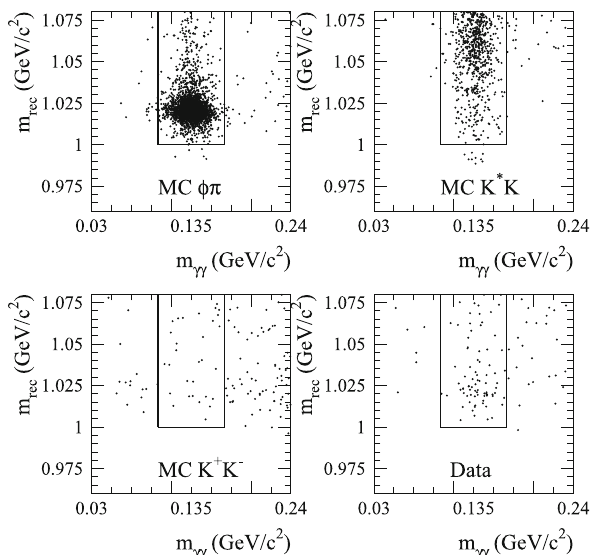
Fig. 9 The two-dimensional m rec versus m γγ distribution for selected data and simulated events of the processes e + e − → φπ 0 → K + K − π 0 , e + e − → K ∗ K → K + K − π 0 , e + e − → K + K − (γ) . The lines indicate the region of invariant masses (1 . 00 < m rec < 1 . 08